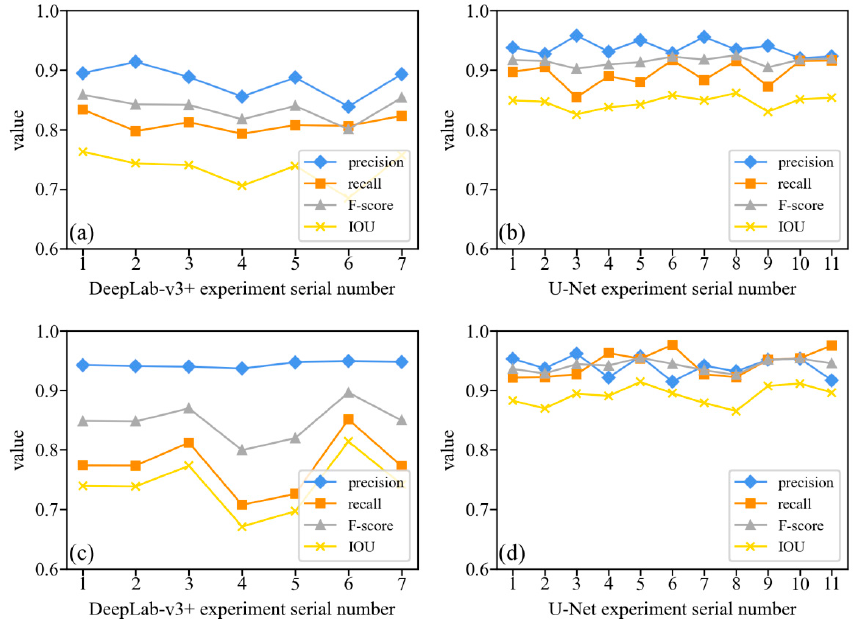
Figure 12. Precision, recall, F-score and IOU of DeepLab-v3+ and U-Net extraction results. ( a ) DeepLab-v3+ extraction results of floating raft aquaculture. ( b ) U-Net extraction results of floating raft aquaculture. ( c ) DeepLab-v3+ extraction results of cage aquaculture. ( d ) U-Net extraction results of cage aquaculture.